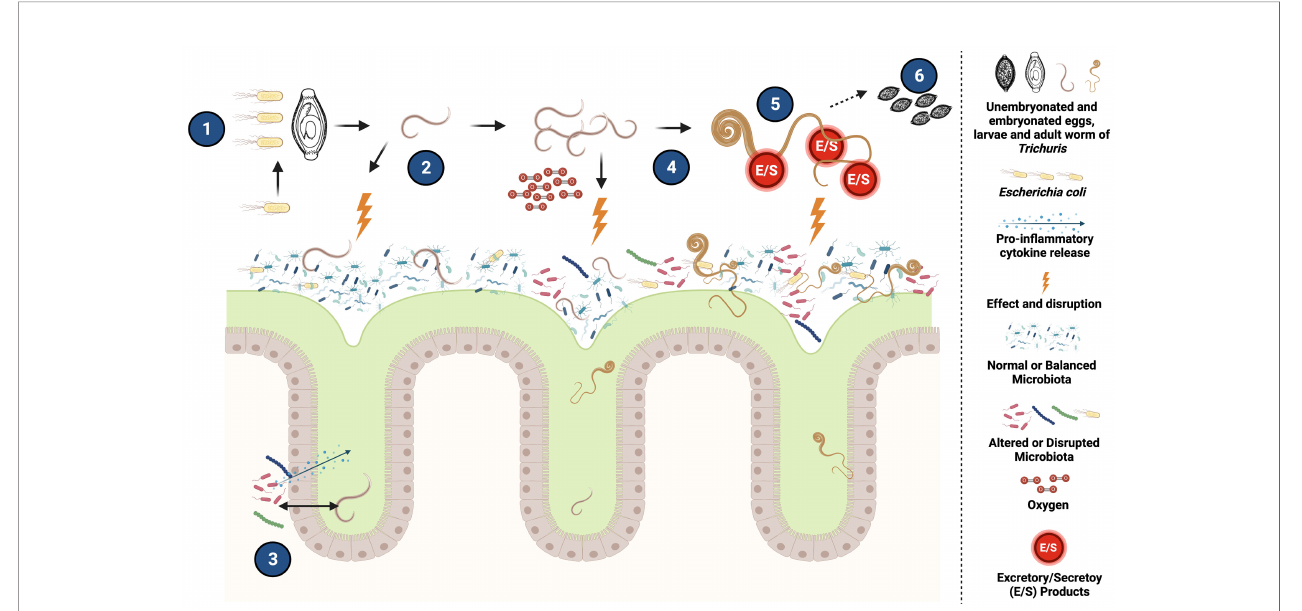
FIGURE 1 | Potential mechanisms of interaction between Trichuris and the host intestinal microbiota. (1) After ingestion of the infective stage of Trichuris , it has been demonstrated that certain bacteria, such as Escherichia coli , can improve the hatching of the eggs, contributing to the establishment of the infection and the development of the parasite. (2) The presence of eggs and released larval stages could cause changes by direct interaction with the host microbiota and by the in fl ammatory response generated by the parasite (3) Likewise, damage to the intestinal epithelium caused by Trichuris can cause translocation of bacteria into the intestinal lumen that may trigger localized in fl ammatory responses that could potentially affect certain commensal bacterial community of the microbiota in fl uencing the composition and structures of the host bacterial communities. (4) The presence of the parasite in the intestine, together with the changes previously caused in the microbiota, generate an increase in oxygen availability and cause a decrease in strict anaerobic bacteria essential for intestinal health (such as Faecalibacterium ) and facilitate the increase offacultative aerobes such as some Enterobacteriaceae that in turn contribute to the development of the infection. (5) Adult forms of Trichuris can generate Excretory/Secretory (E/S) products that, in addition to having an immunomodulatory effect, can have an impact on certain bacterial groups of the intestinal microbiota, modifying its structure and composition. (6) The adult forms produce eggs that that will be eliminated in the feces. Created with